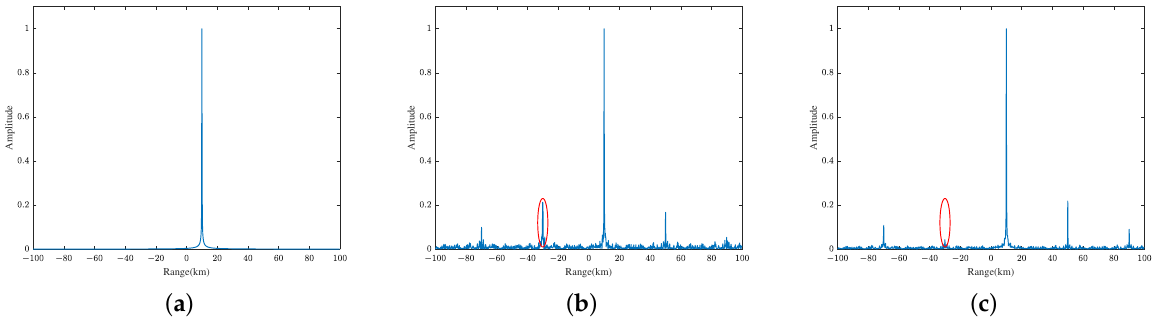
Figure 3. The range profiles of a point target located at 10 km with a high oversampling rate set to 20. ( a ) Results with high-precision quantization. ( b ) Results with one-bit quantization. ( c ) Results with the proposed two-bit